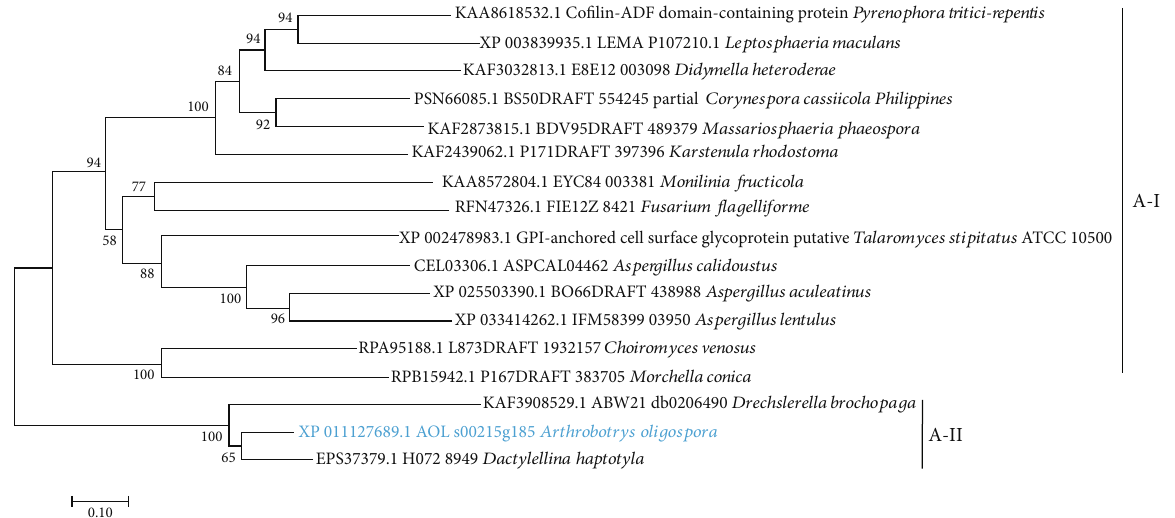
Figure 1: Phylogenetic analysis of homologous Aog185 protein from di ff erent fungi based on their deduced amino acid sequences. GenBank accession number is given. These proteins were clustered into 2 groups (A-I and A-II).